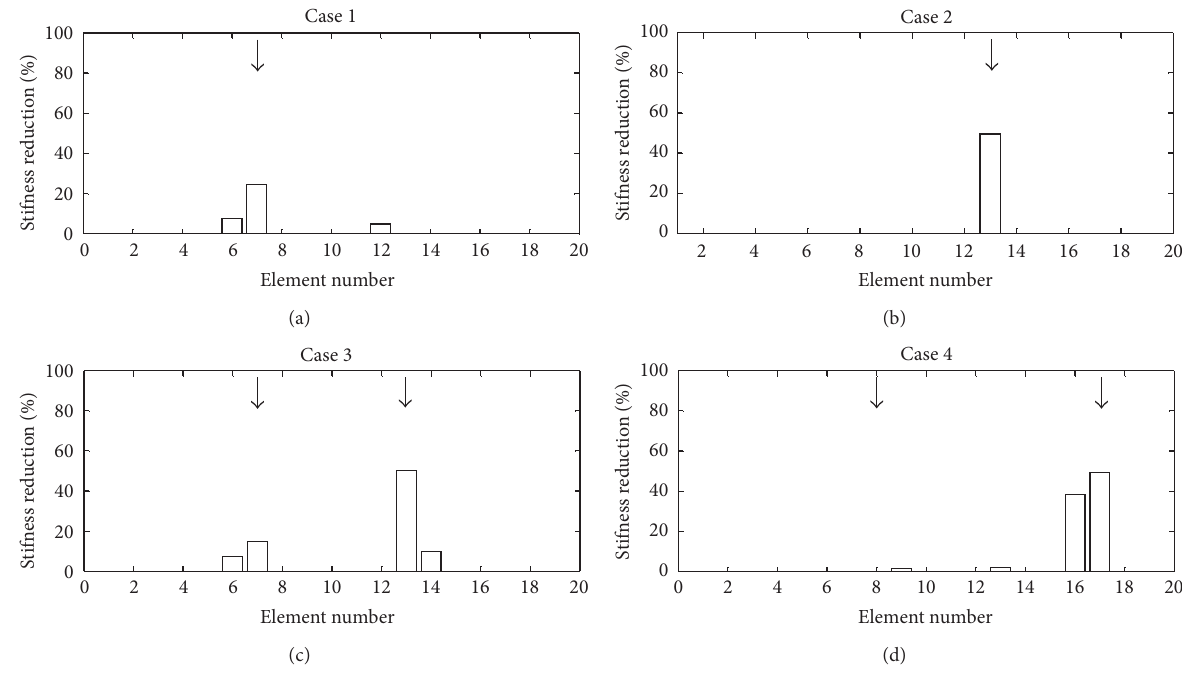
Figure 14: Experimental reduction of stiffness detected at each